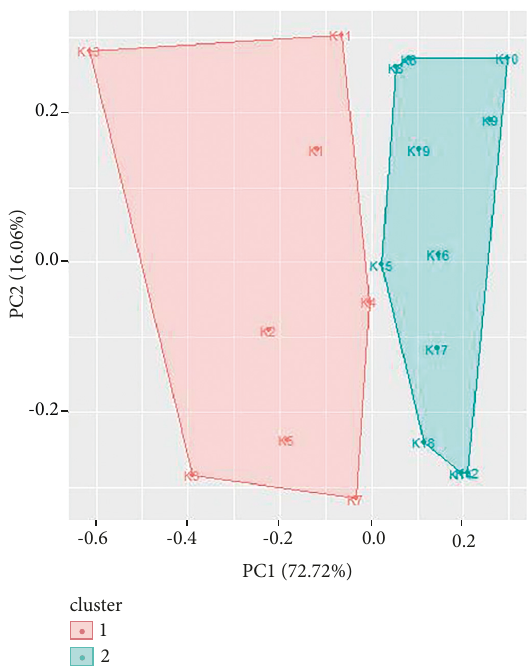
Figure 10: Cluster analysis for UV/Vis spectroscopy data for black ballpoint pen